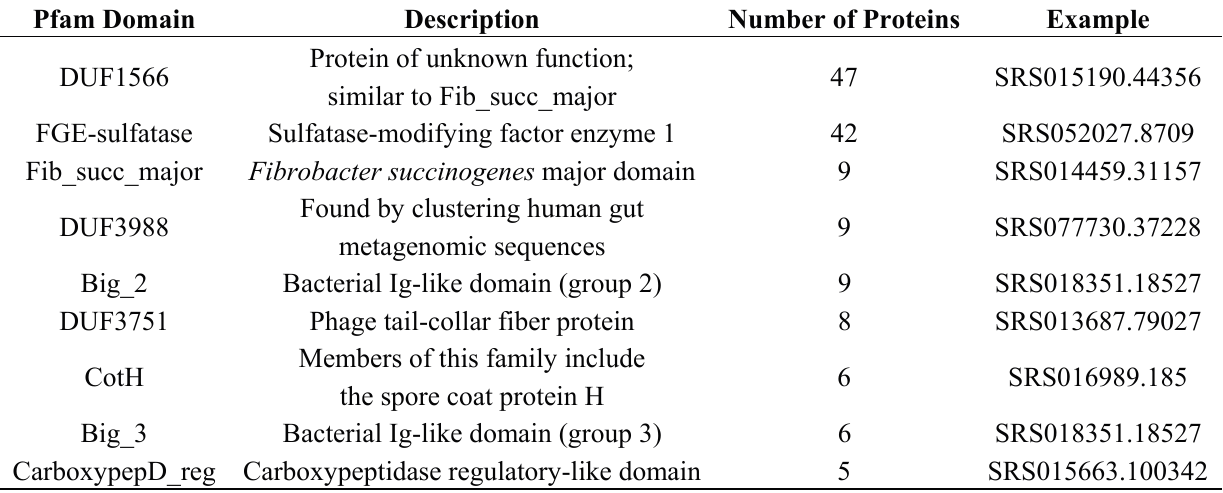
Table 2. Breakdown of the functions (PFAM domains) assigned to the putative variable proteins identified from the HMP